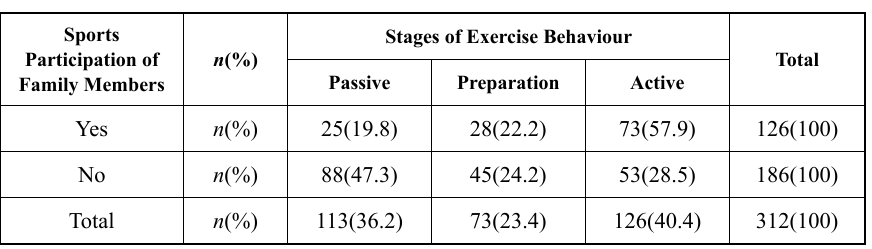
Table 5b. The distribution of SHS scores according to sports participation of family members Note. M = Mean; SD = Standard